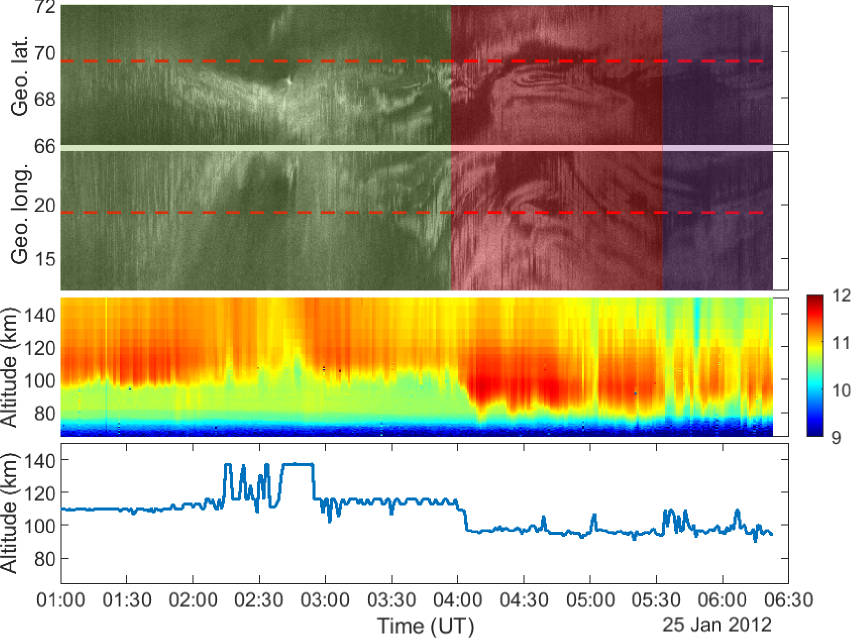
Figure 3. Keogram, ewogram, EISCAT electron density, and altitude of maximum electron density on 25 January 2012. Color-coded rectan- gles and dashed red lines are PsA types and EISCAT FOV respectively, the same as in Fig.